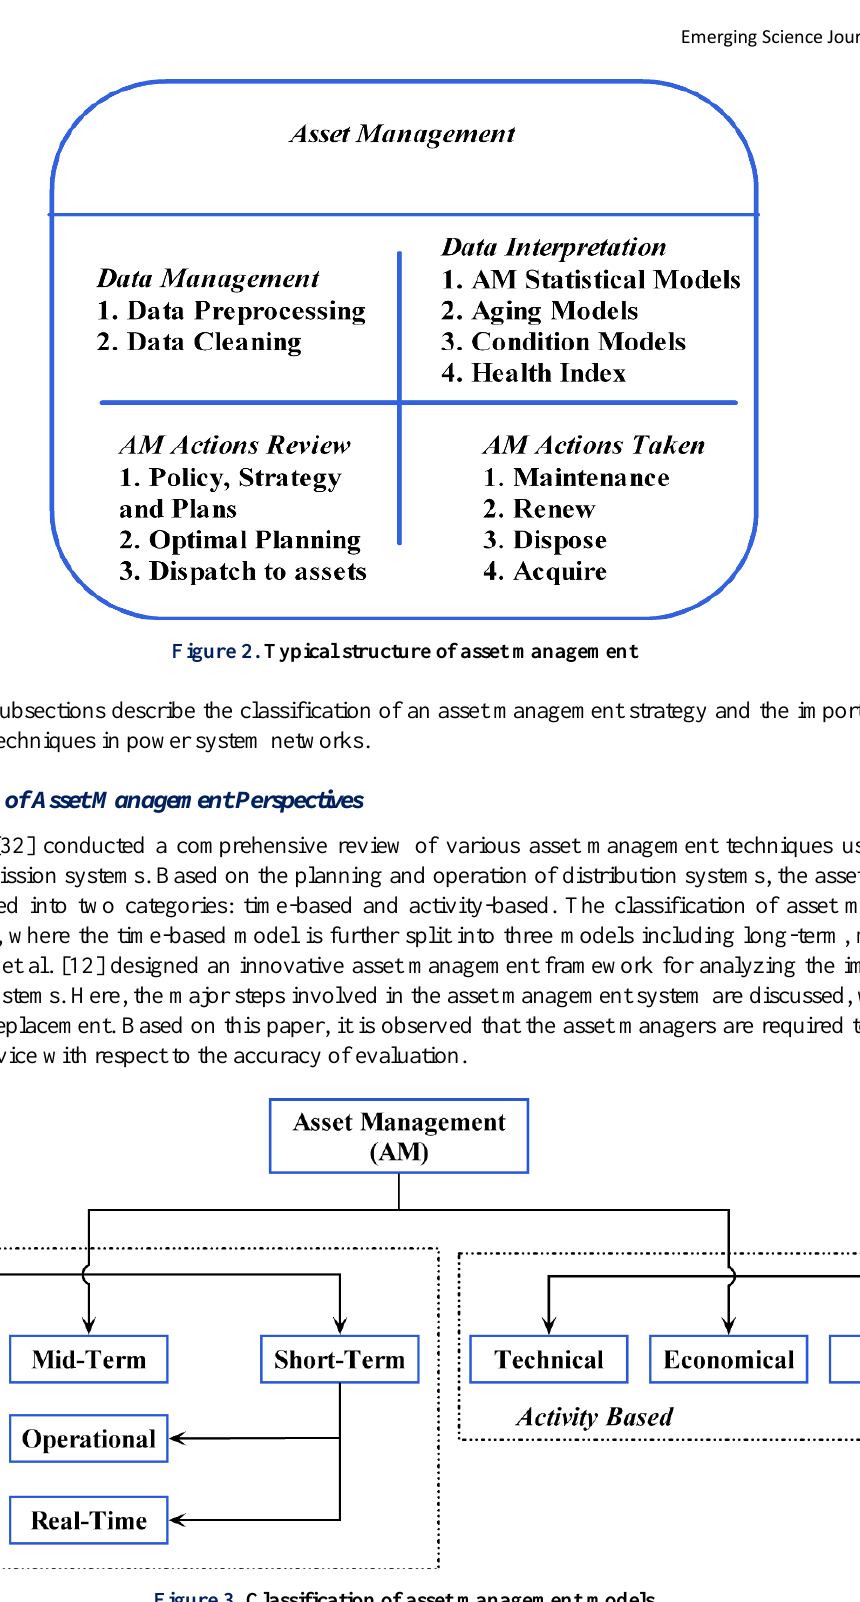
Figure 3. Classification of asset management